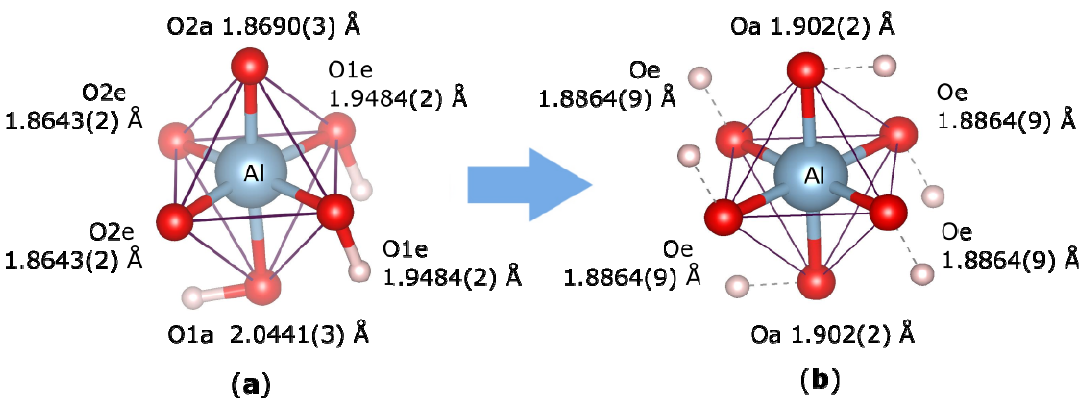
Figure 2. AlO 6 octahedron at ambient pressure ( a ) and after transition at ~10.19 GPa ( b ).